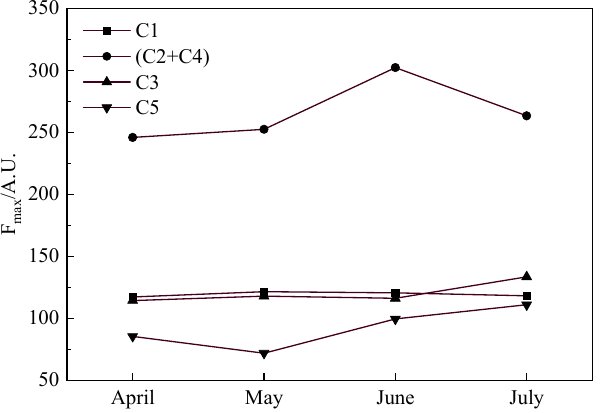
Figure 6. Variation components of DOM component content in spring (April to June) and summer (July). The variation of spectral indices such as FI, BIX, and HIX in the area of the lake was analyzed over time. There was some spatial and temporal variation among the fluorescence index values in the area of the lake: the FI was ranging from 1.58 to 2.08 with a mean value of 1.68 ± 0.10 (1.4 < FI < 1.9) (Table 3), which indicated that the DOM of Shahu Lake has dual properties of internal and external sources [14]. The average of FI in